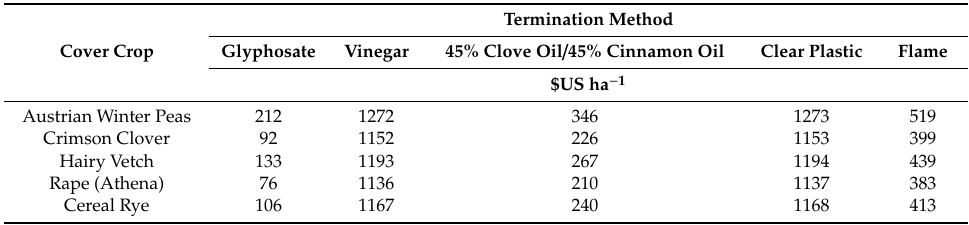
Table 6. Total variable costs (including seed and termination method costs) by cover crop and termination method ($US ha − 1